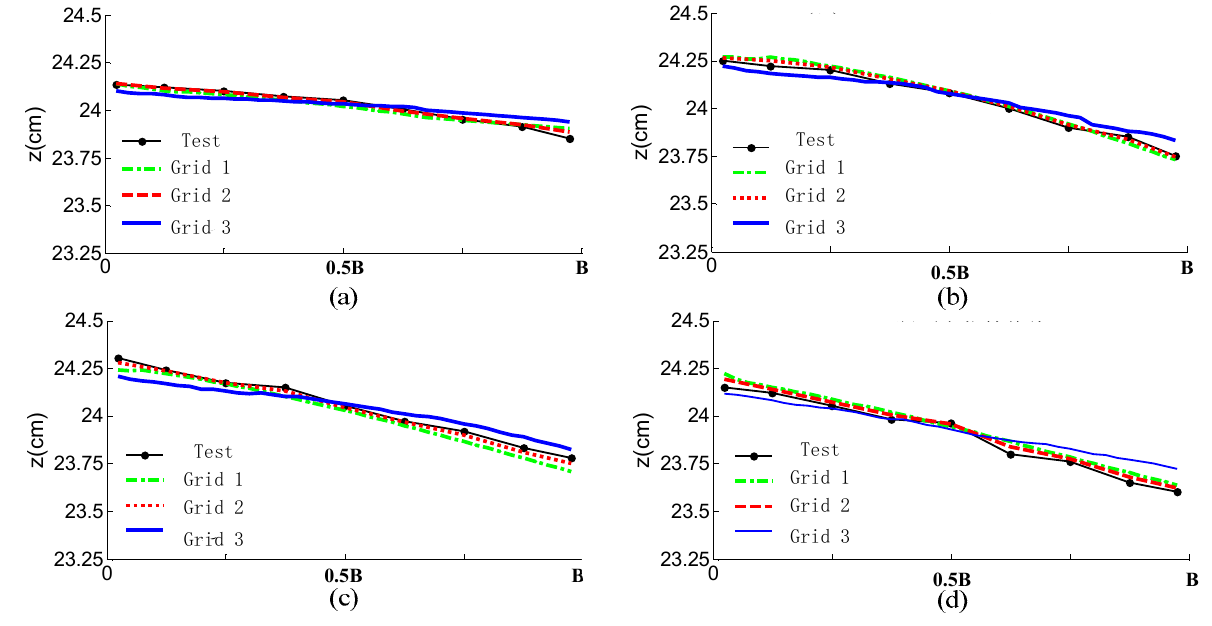
Figure 3. Comparison of water lines for sections: ( a ) D0; ( b ) D45; ( c ) D90; and ( d ) D135.